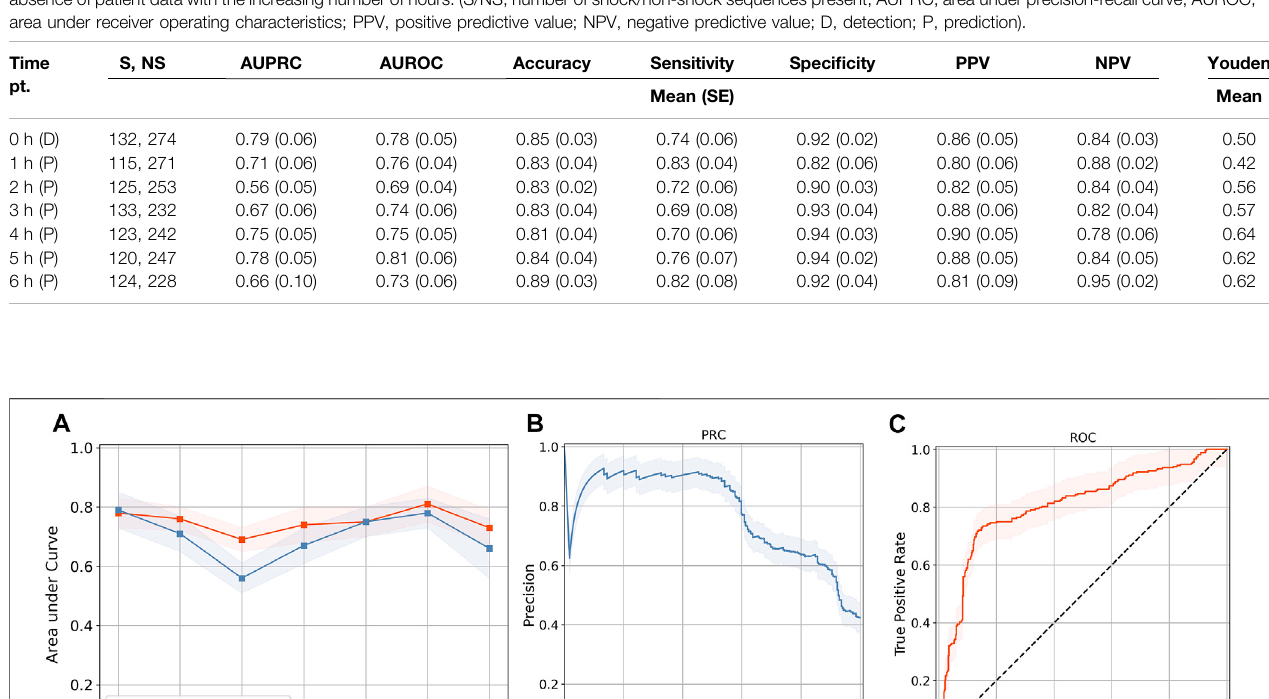
Frontiers in Physiology |